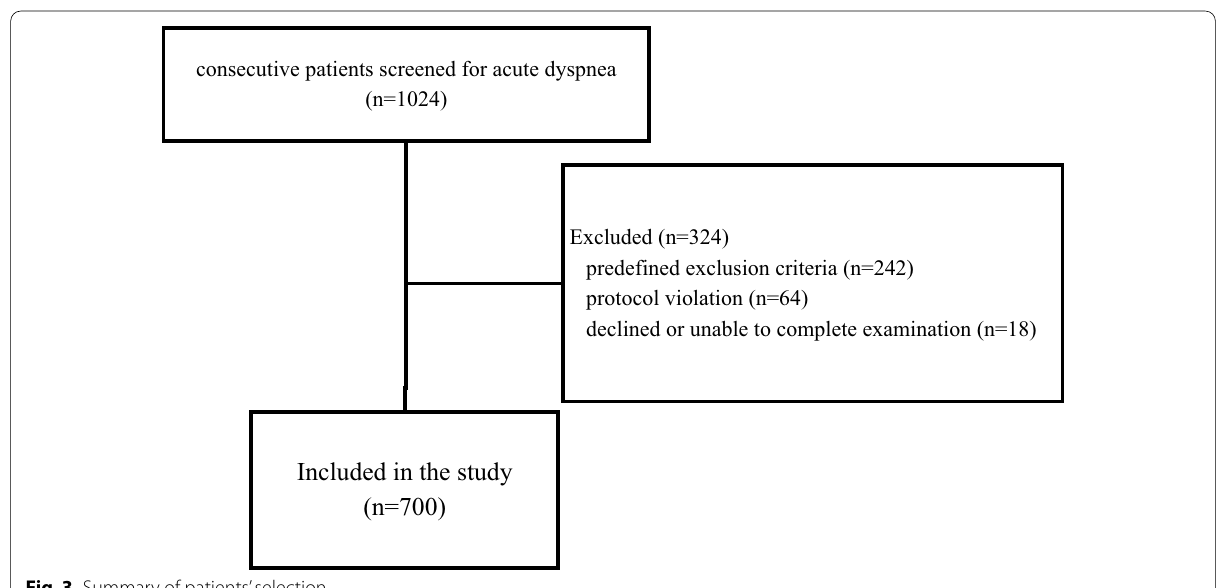
Fig. 3 Summary of patients’